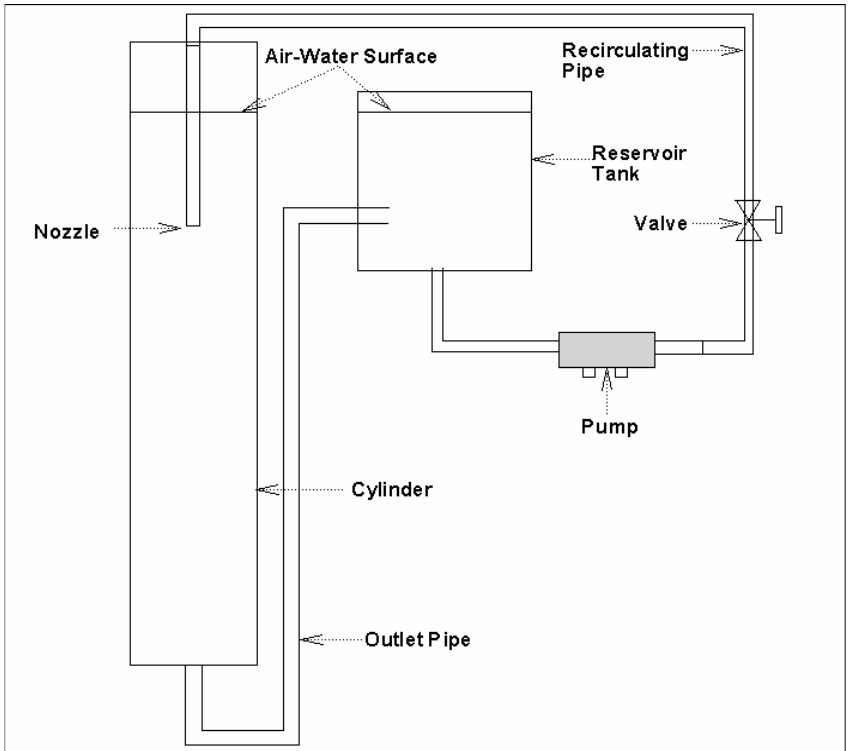
Figure 2: Experimental Set Up of the Submerged Liquid